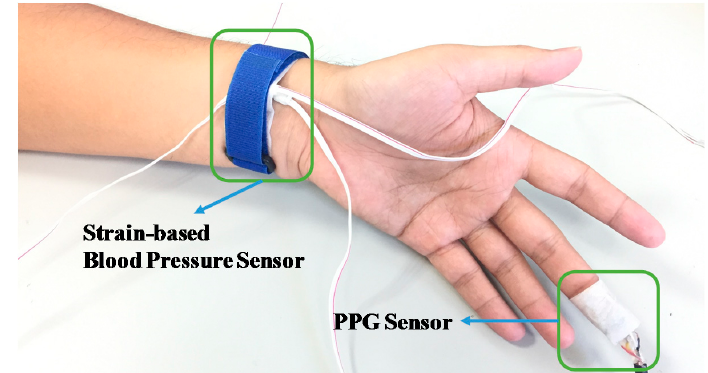
Figure 11. Photograph of a participant’s hand with the proposed high-sensitivity BP monitoring system.